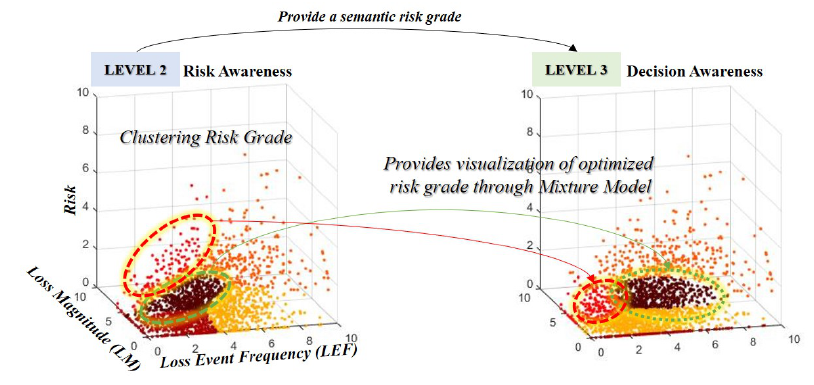
Figure 7. Clustering and optimization methods were combined with risk measurement and situational model to provide semantic visualization of risk grade.